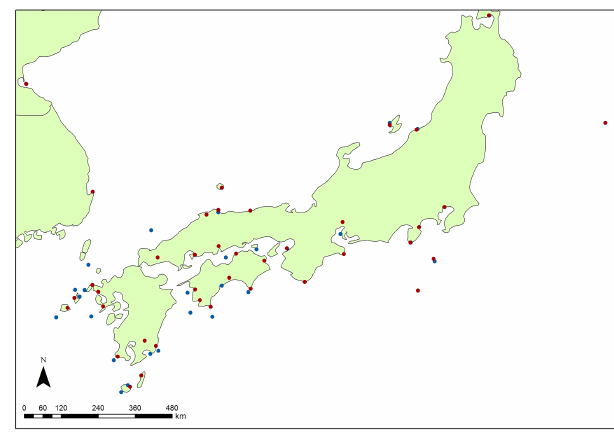
Figure 7. Map of the updated station location (red dots) for Mexico. No original location coordinates were available.